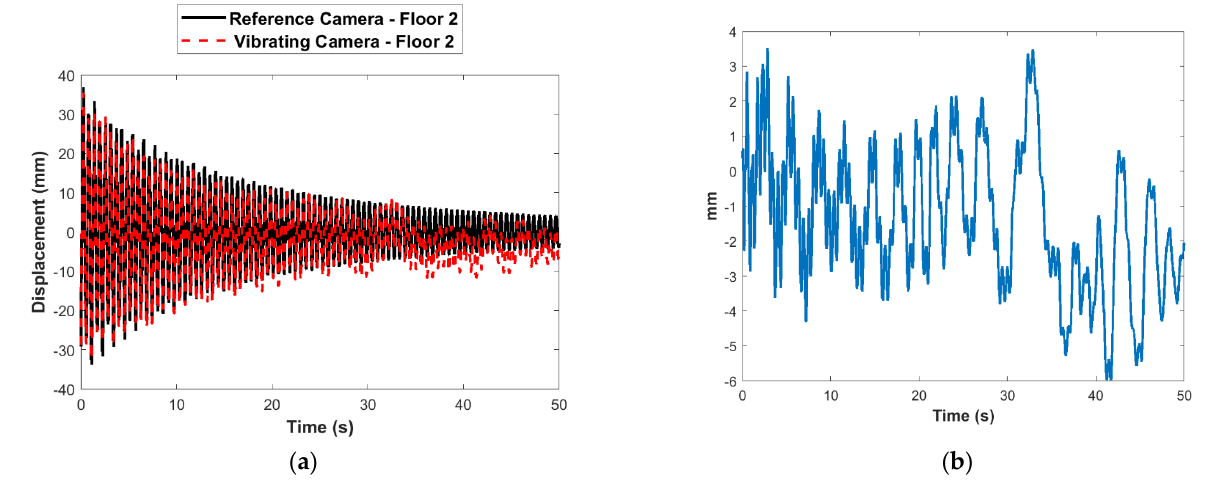
Figure 13. Comparison of estimated and reference second-story displacement: ( a ) in time domain before compensation of vibrating camera; ( b ) errors before compensation of vibrating camera.